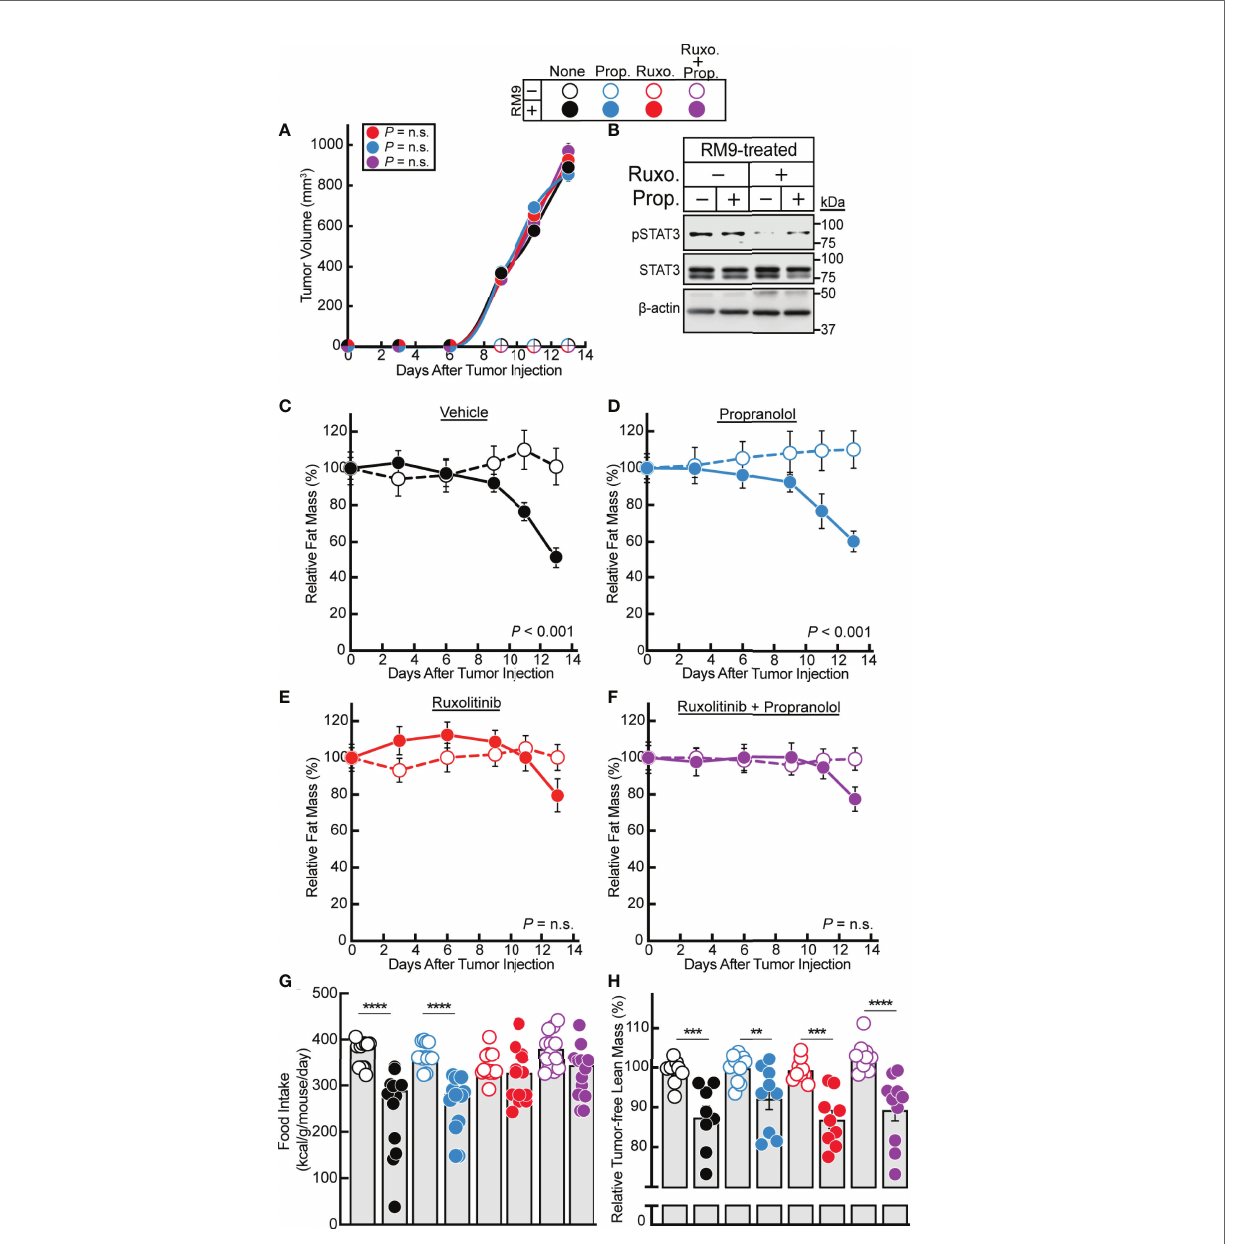
FIGURE 4 | Effect of JAK and b -adrenergic Inhibitors on RM9 Cancer Cachexia Adipose Wasting. (A – H) Chow-fed C57BL/6 J mice (12-week old male mice, 4 mice/cohort) were injected s.c. in their right fl ank with PBS in the absence ( open circles ) or presence ( closed circles) of 1x10 6 RM9 cells on day 0 followed by i.p. administration of 150 µl PBS containing 2% DMSO (v/v) and 30% PEG300 (v/v) in the absence ( black ) or presence of 10 mg/kg propranolol (blue, Prop. ), 50 mg/kg ruxolitinib ( red, Ruxo. ), or a combination of both compounds ( purple, Ruxo. + Prop. ) twice daily. Tumor volume (A) , immunoblot analysis of harvested white adipose tissue with the indicated antibodies (B) , and fat mass (C – F) , food intake (G) , and tumor-free lean mass (H) were measured at the indicated time points (A, C – F) or at sacri fi ce (B, G, H) as described in Methods . Fat and lean mass are shown relative to the average day 0 reference value for each respective cohort. The average fat mass values at day 0 for the mouse cohorts without RM9 cells were 3.1 g, 3.2 g, 3.0 g, and 3.0 g and with RM9 cells were 3.1 g, 3.3 g, 3.1 g, and 3.2 g for vehicle, propranolol, ruxolitinib, and both ruxolitinib and propranolol conditions, respectively. The average lean mass values at day 0 for the mouse cohorts without RM9 cells were 20.5 g, 20.2 g, 20.2 g, and 22.8 g and with RM9 cells were 20.2 g, 21.7 g, 21.1 g, and 21.8 g for vehicle, propranolol, ruxolitinib, and both ruxolitinib and propranolol conditions, respectively. Data are shown as mean ± SEM (A, C – F) or dot plots with bars representing mean ± SEM (B, G, H) . ** p < 0.01, *** p < 0.01, and **** p < 0.001 or P value calculated by using a two-way repeated measures ANOVA (A, C – F) or by two-way ANOVA followed by Sidak ’ s multiple comparison test (G, H) to compare RM9 cohorts in the absence or presence of treatment (A) or matched PBS- and RM9-treated cohorts (C – H) . Not signi fi cant